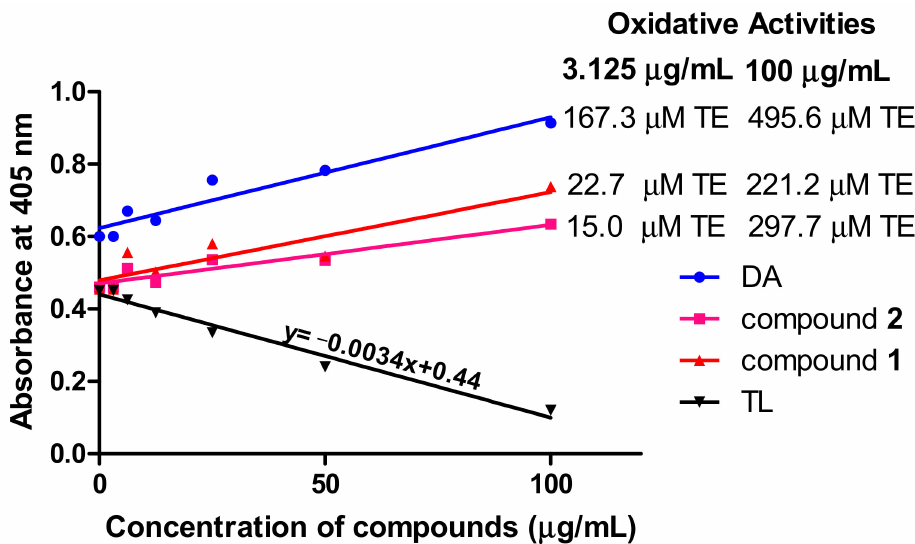
Figure 6. Oxidant capacity of compounds in T. brucei . In contrast to the standard antioxidant Trolox, the compounds were oxidative in their antitrypanosomal activities. Oxidative activities of compounds were calculated from the equation of the standard Trolox curve. DA = diminazene aceturate; TL = Trolox; TE = Trolox